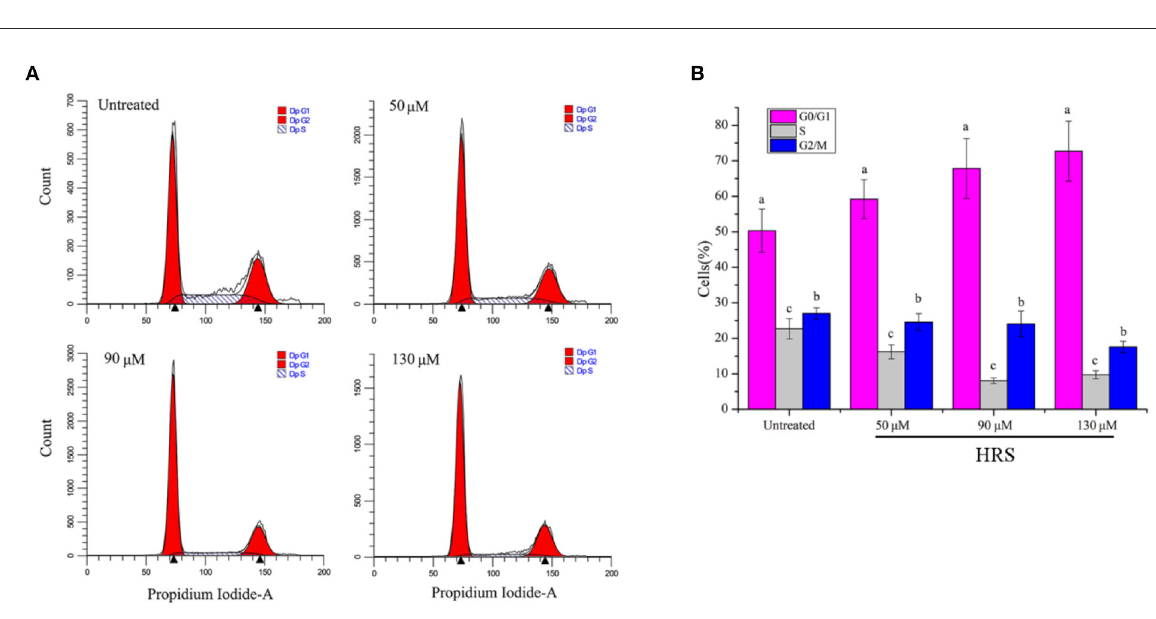
FIGURE5 Hydroxy- γ -sanshool (HRS) induced cell cycle arrest at G1 phase in HCT-116 cell lines. (A) Cells in various cell cycle stages after HRS-treatment. (B) Percentages of cells in various cell cycle stages after treatment with HRS for 24h. a − c Within a concentration, columns without a common superscript differed ( p <